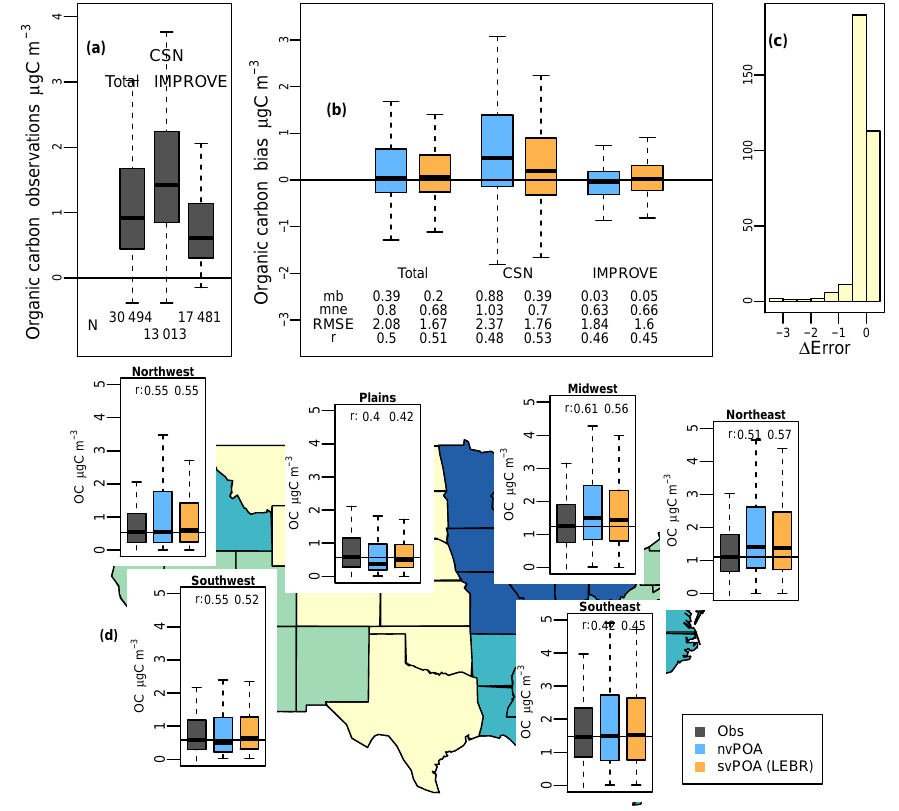
Figure 8. Continent-wide organic carbon (OC) evaluation of the nvPOA case and the best-performing sensitivity case (LEBR) against routine-monitoring data from IMPROVE and CSN sites for an annual simulation during 2011. (a) Distribution of OC observations from both networks individually and combined. (b) Distributions of OC bias for each network and combined. (c) Histogram of error changes from the nvPOA to the svPOA (LEBR) case at specific stations aggregated throughout the year. (d) Regional distribution of OC observations and predictions throughout the annual simulation.